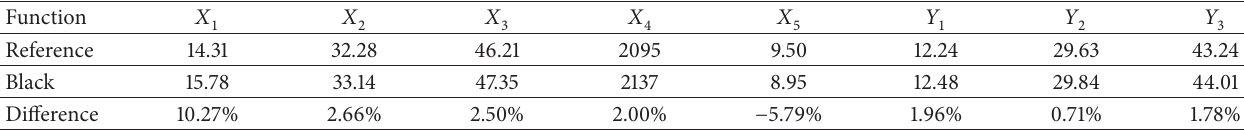
Table 9: Results obtained from the second model.